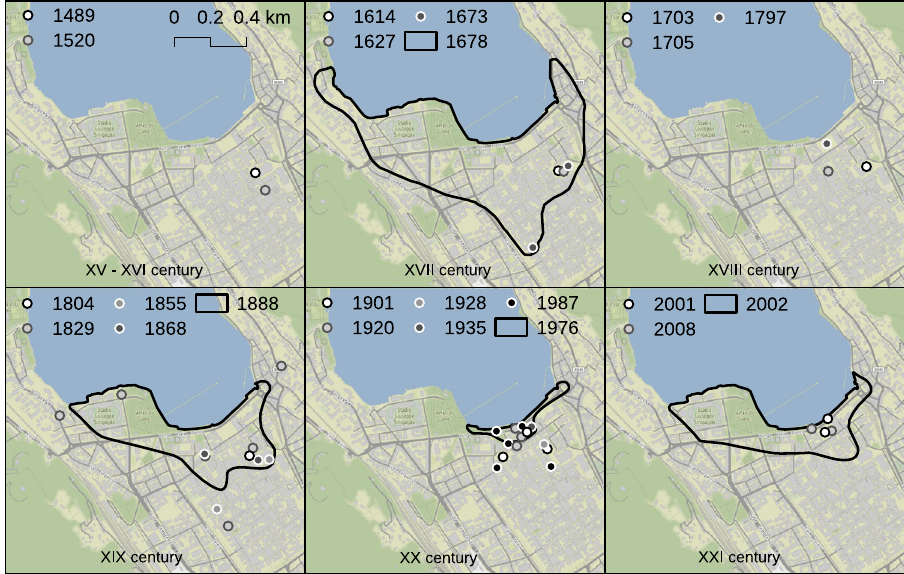
Fig. 2 Spatial extent of some fl ood events affecting the town of Como. Information about the impact of some fl ood events. For some events the reconstructed fl ooded area is reported, while for others only locations that are known to have been reached by water. Flooded data are provided by Regione Lombardia with CC-BY-NC-SA 3.0 Italy license and can be downloaded from the Lombardy Geoportal. Source of the basemap: map tiles by Stamen Design, under CC BY 3.0, and data by OpenStreetMap, under